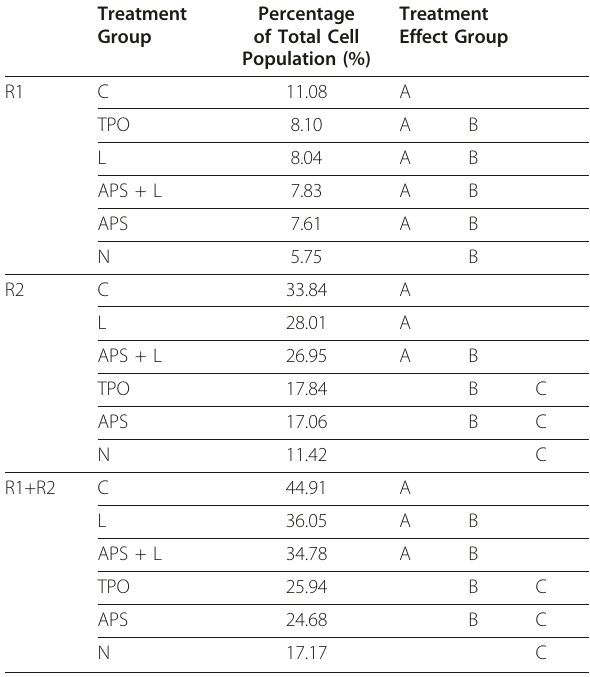
A, B, C and D stand for treatment groups having significantly different treatment effects. N: Normal, cells cultured in the presence of cytokine and serum; C: Control, cells grown in cytokine and serum-depleted media; R1: early apoptotic cell; R2: late apoptotic cell; R1+R2: total apoptotic cell;